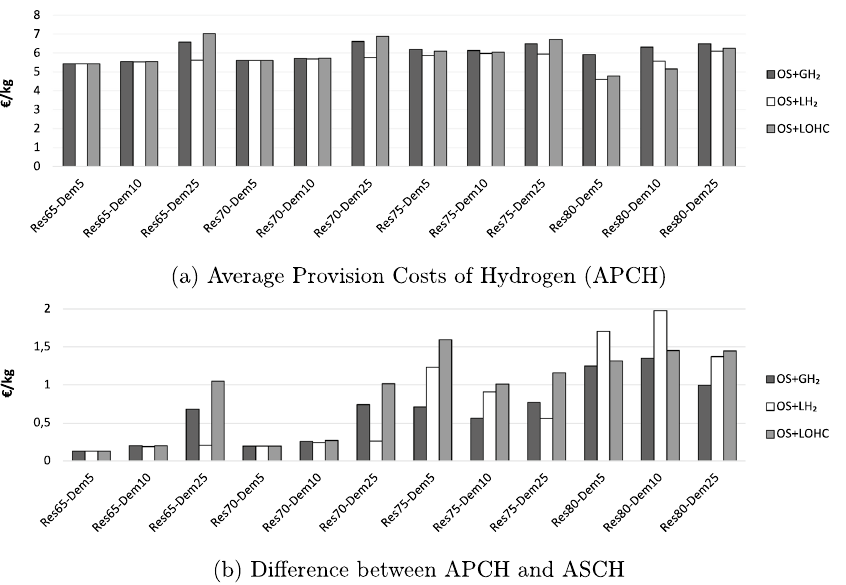
Figure 8. Average provision costs of hydrogen (APCH) and differences to additional system costs of hydrogen (ASCH).